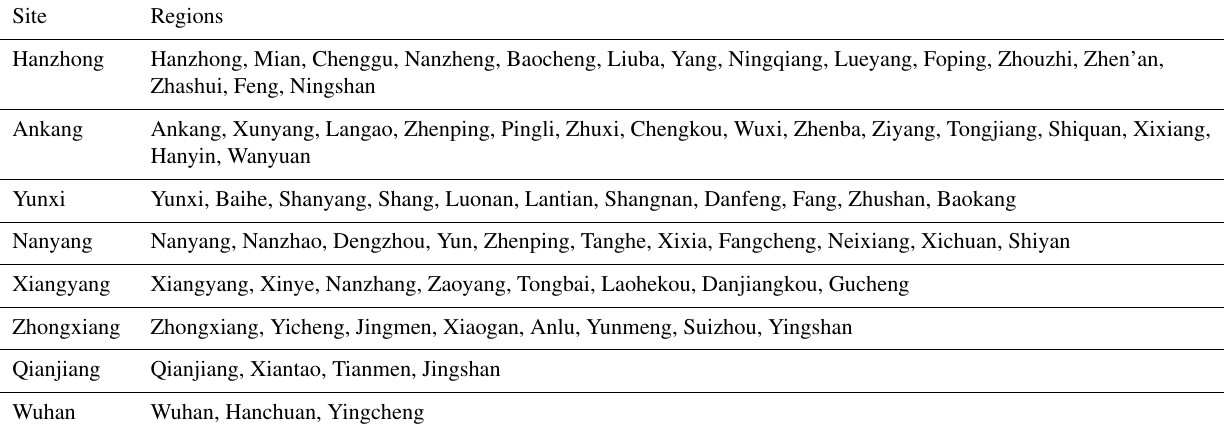
Table 2. Eight sites of drought and flood grade sequence and the spatial ranges (regions) they represented in the HRB during 1426–1950. Site